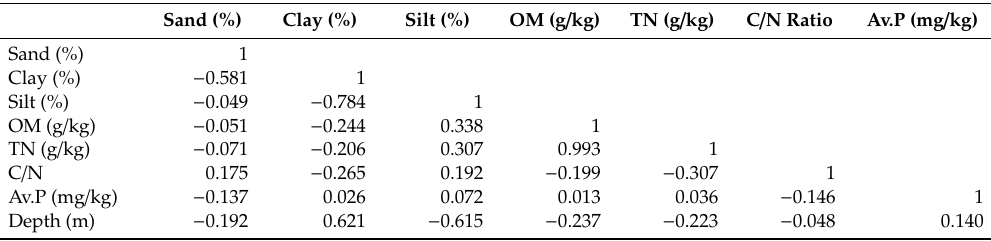
Figure 6. Bottom sediment texture of Lake Tana: ( a ) silt content with lake depth and ( b ) clay content with lake depth. Table 1. Pearson correlation coe ffi cient for bottom sediment properties of Lake Tana. OM is organic matter; TN is total N. and Av.P is available